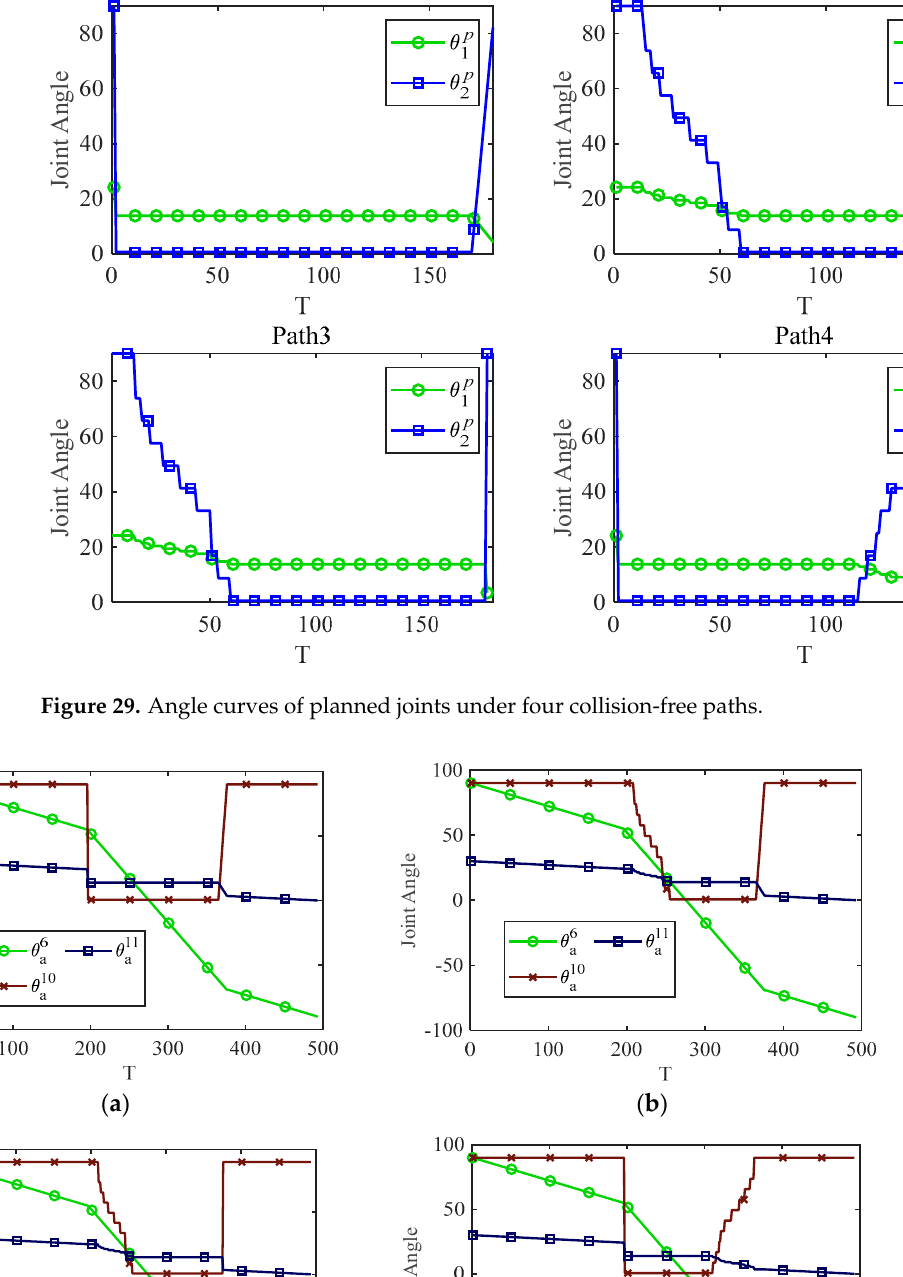
( d ) Figure 31. Reconfiguration processes of SMSRS under four collision-free paths. ( a ) path 1, ( b ) path 2, ( c ) path 3 and ( d ) path 4.